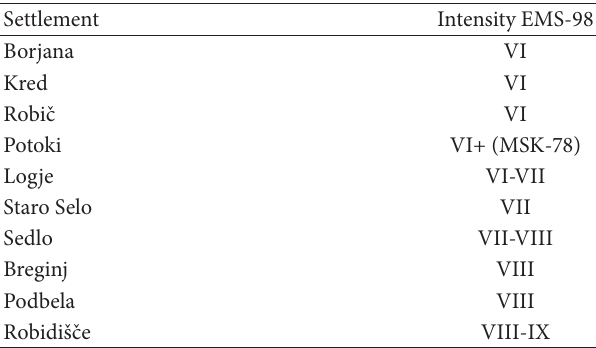
Table 2: Intensities of 1976 earthquake in different settlements of Breginjski kot. Settlement Intensity